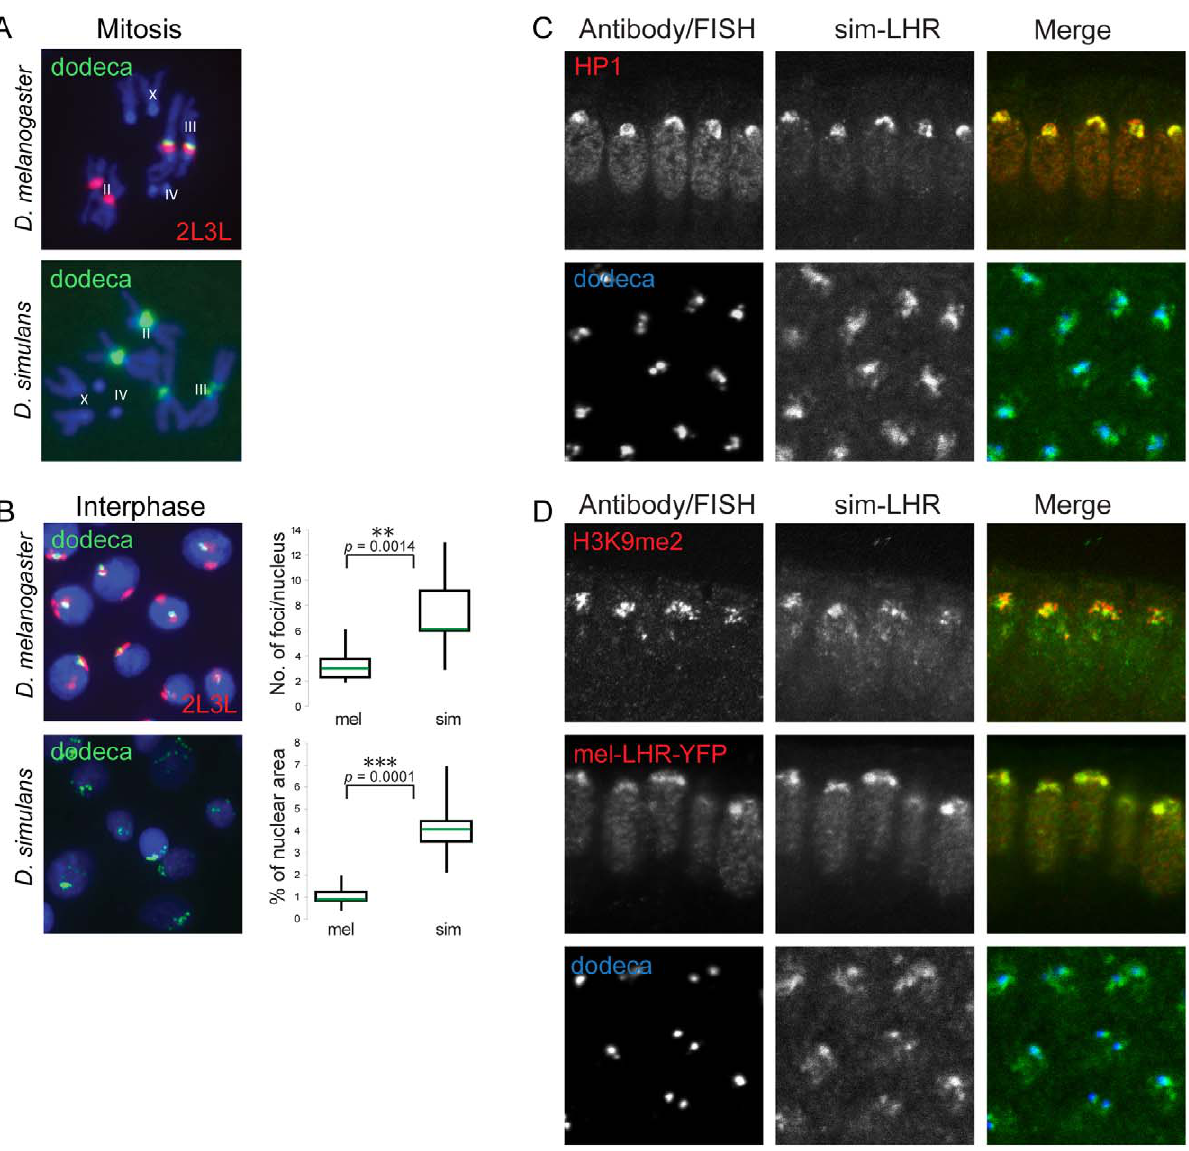
Figure 3. LHR orthologs have conserved localization properties despite species-specific divergence of heterochromatin. (A,B) The dodeca satellite has diverged in its chromosomal location and interphase organization between D. melanogaster and D. simulans . FISH to mitotic (A) and interphase (B) nuclei from 3 rd instar larval brain cells with probes to dodeca (green) and 2L3L (red). Right panels in part B show quantification of the nuclear distribution of the interphase dodeca FISH signals. The mean values are indicated by the green lines (n=10 for each sample).Boxes span the interquartile range and whiskers extend to the maximum and minimum values. Significance was tested by Wilcoxon rank-sum test. mel= D. melanogaster ; sim= D. simulans . (C, D) Conserved heterochromatic localization properties of LHR orthologs. (C) sim-Lhr-HA transgene in D. simulans embryos. Top panel, Anti-HA (green) detects sim-LHR-HA colocalizing with HP1 (red) in the apical heterochromatin. Bottom panel, sim-LHR-HA (green) partially colocalizes with dodeca satellite (blue). (D) sim-LHR-HA (green) expressed in D. melanogaster embryos colocalizes with H3K9me2 (red) and with mel-LHR-YFP, detected with anti-GFP (red). sim-LHR-HA also partially overlaps with the D. melanogaster dodeca satellite (blue).